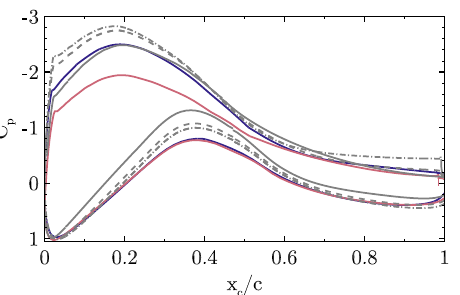
Figure 14. Pressure coefficient C p at r/R = 0 . 136 for CaseIsoRotor (solid red) and CaseT1.0 (solid blue) compared with two-dimensional simulations (gray lines): α = 10 . 2 ◦ (solid), α = 13 ◦ (dashed), α = 14 ◦ (dashed